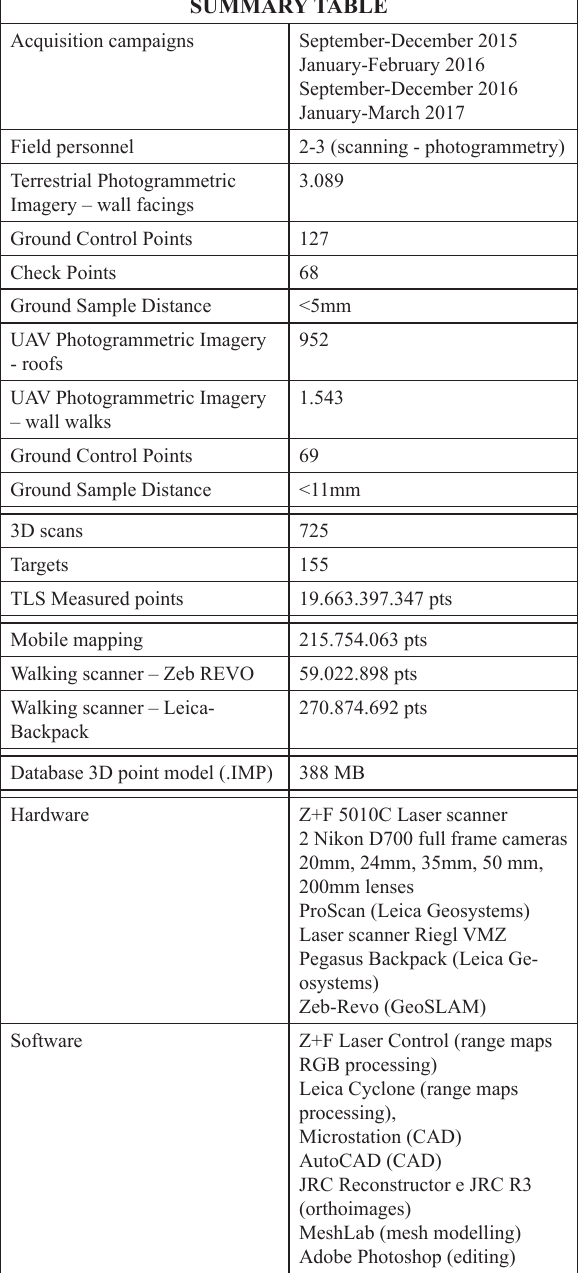
Table 1. Summary of the most relevant data of the